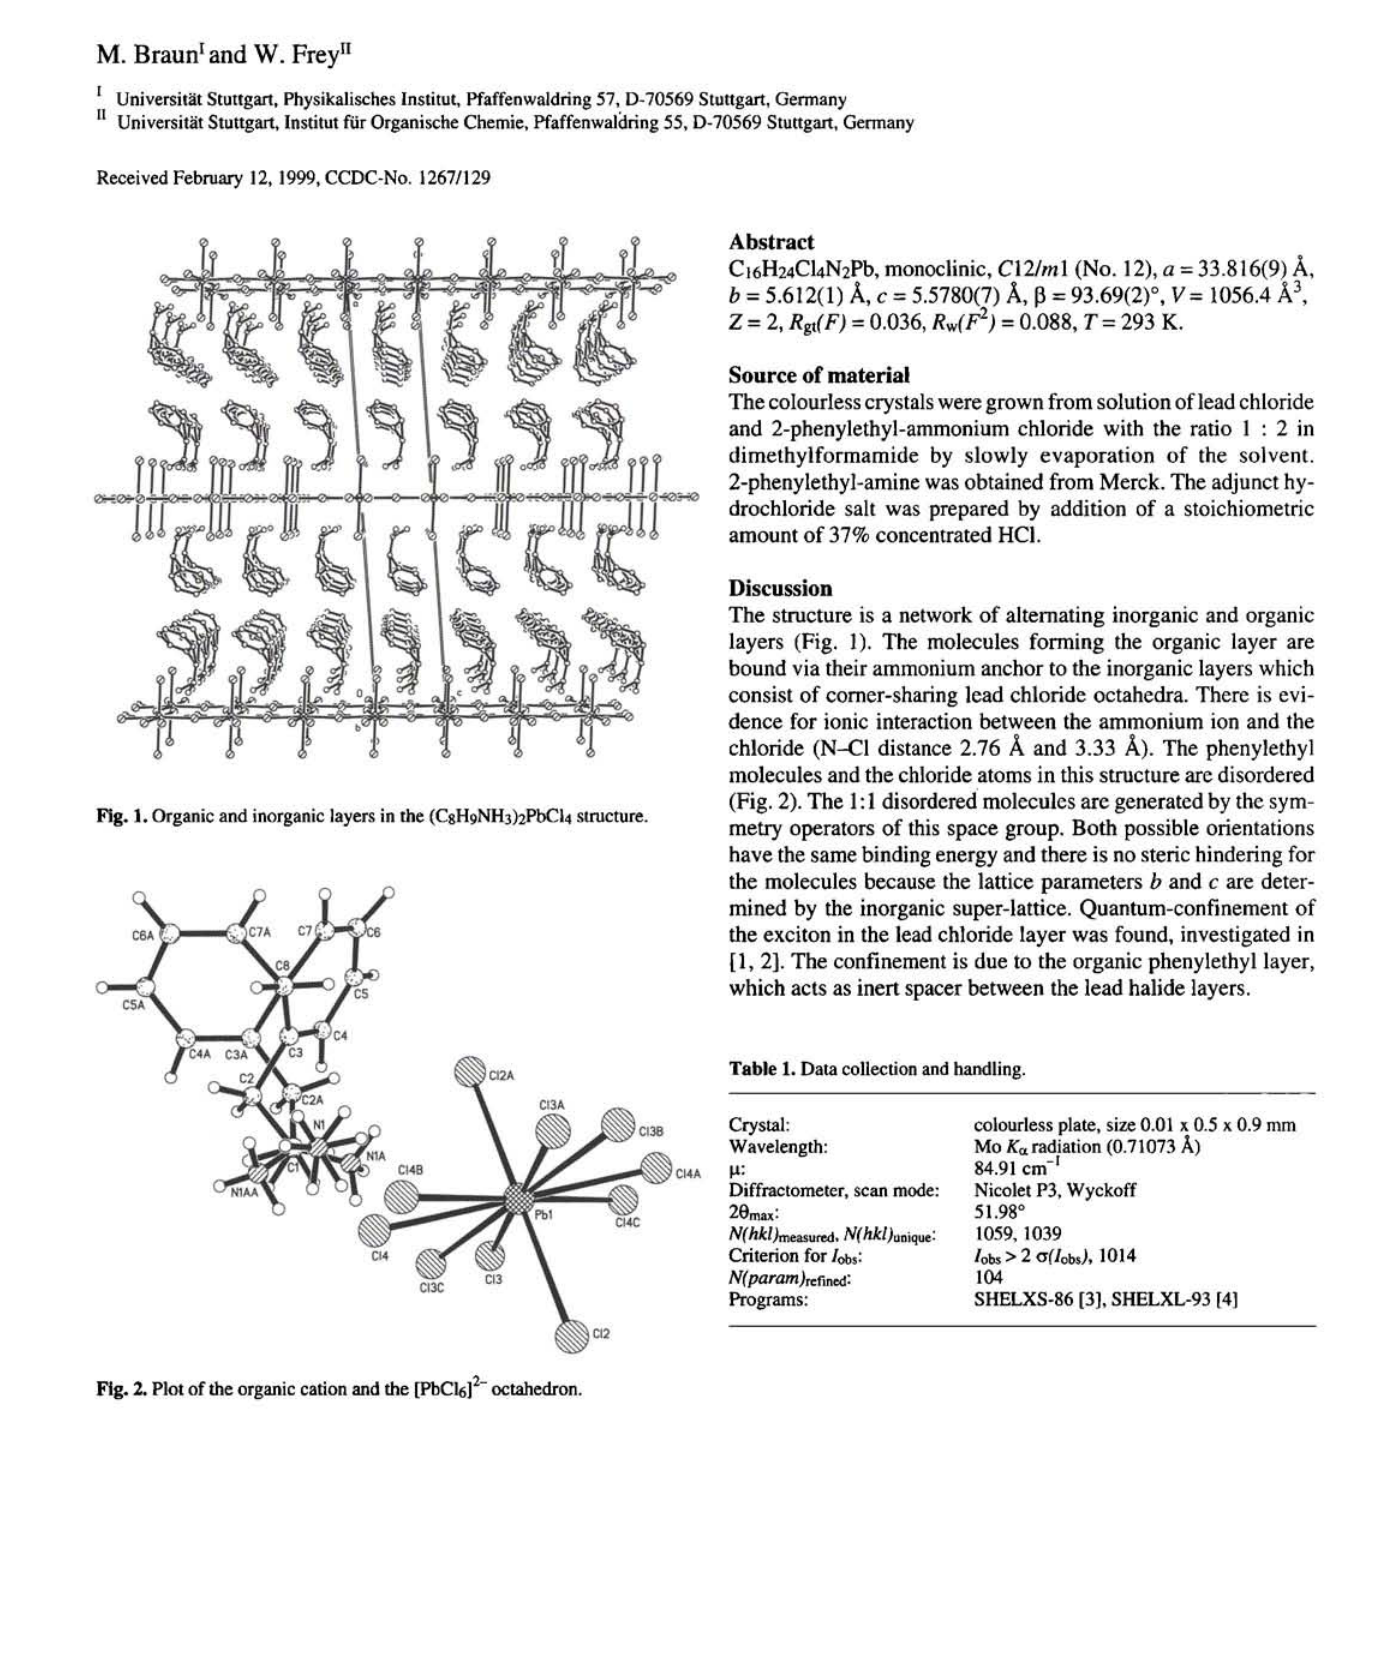
Fig. 2. Plot of the organic cation and the [PbCle] 2